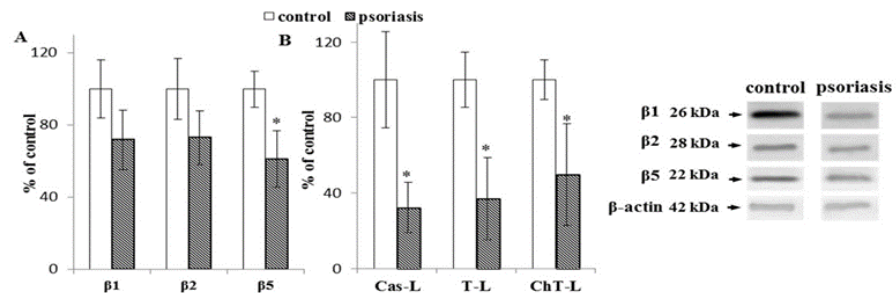
Figure 3. ( A ) Expression of the constitutive proteasome ( β 1, β 2, β 5) and immunoproteasome ( β 1i, β 2i, β 5i) subunits in erythrocytes from patients with psoriasis ( n = 6), in comparison to healthy subjects (control), ( n = 6). ( B ) Caspase-like (Cas-L), trypsin-like (T-L), and chymotrypsin-like (ChT-L) activities of the proteasomes in erythrocytes from patients with psoriasis ( n = 16) and healthy subjects (control), ( n = 12). Values in ( A ) and ( B ) are expressed as a percentage of control. ∗ —statistical significance at p < 0.05 vs. control.